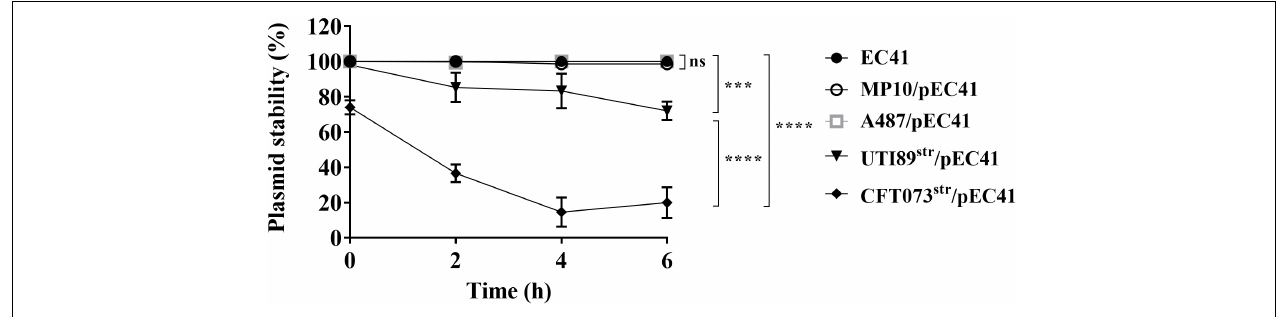
FIGURE 4 | The stability of pEC41 in different E. coli host strains. The stability of pEC41 in EC41, MP10, A487, UTI89 str , and CFT073 str was evaluated. The percentage of pEC41-containing cells was determined by measuring the percentage of ampicillin-resistant cells at the indicated time points. The experiments were performed in triplicate and are presented as the means ± SD. *** P < 0.001, **** P < 0.0001; ns, no significant difference (one-way